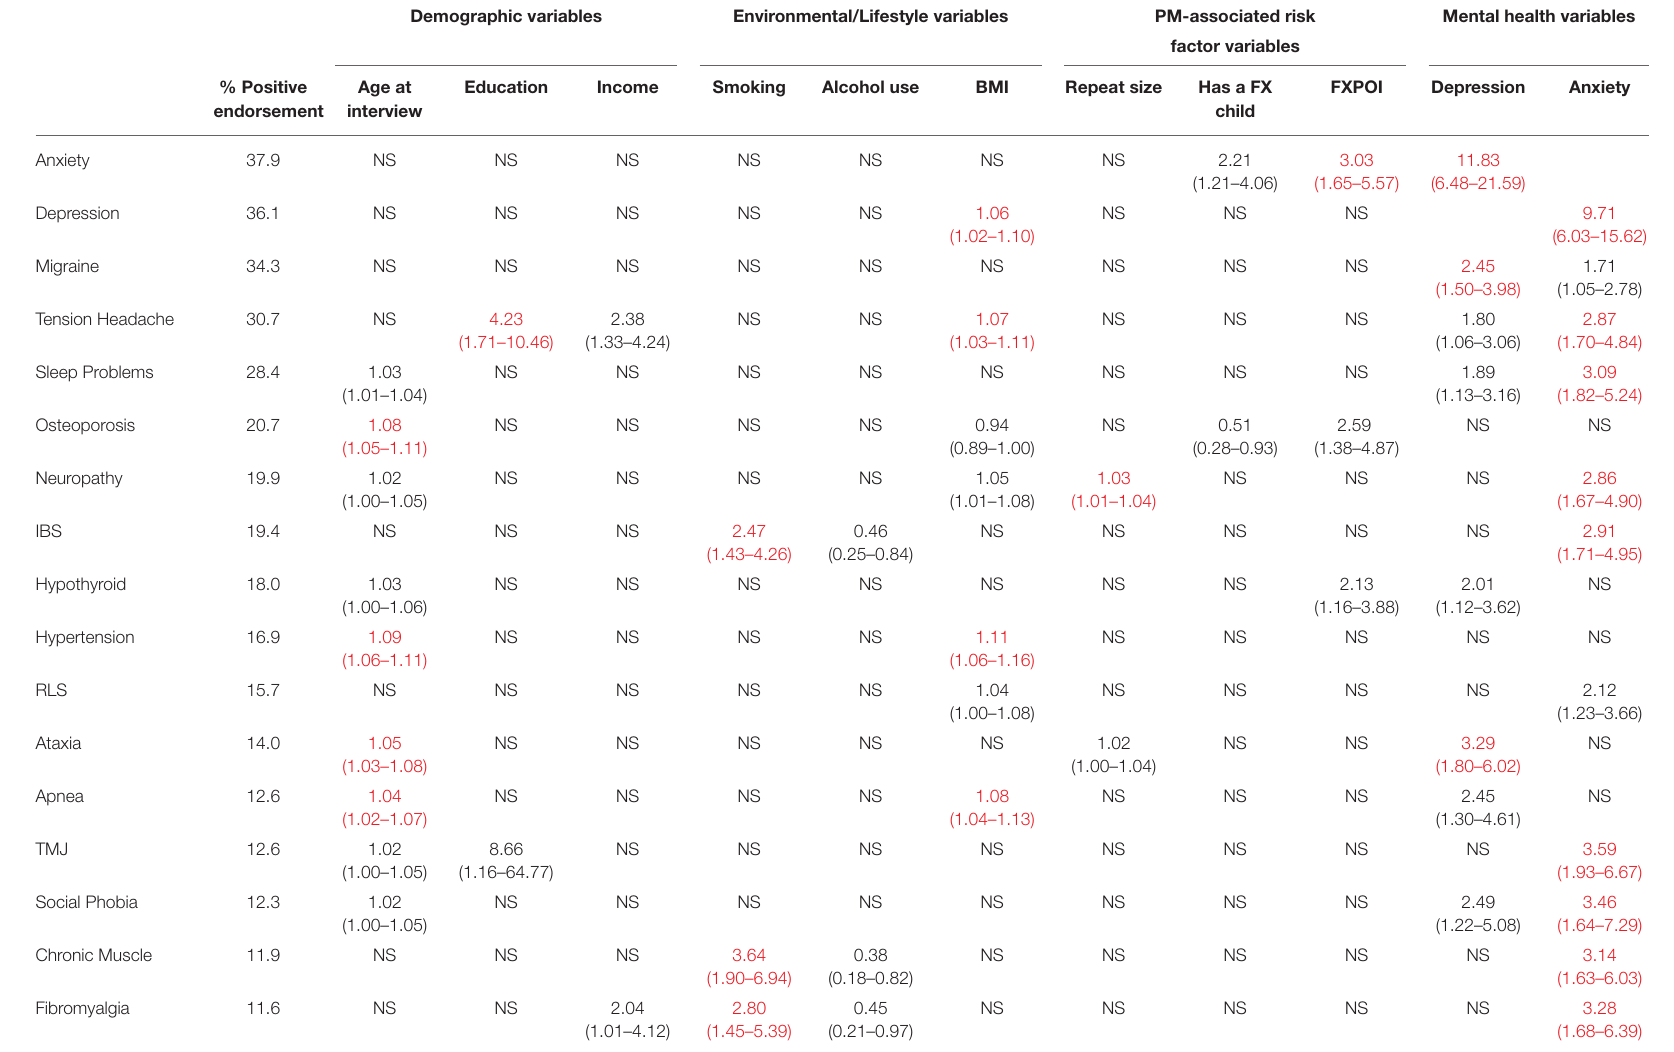
TABLE 2 | Prediction models for each comorbid